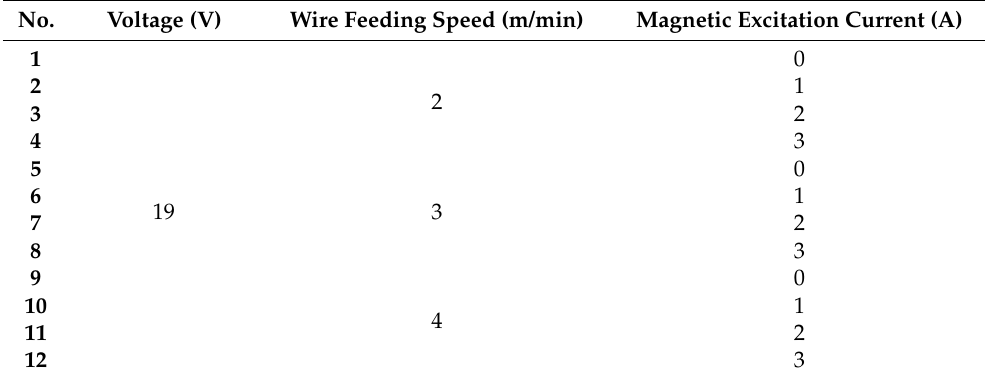
Table 1. Parameters of Ti-6Al-4V alloy in